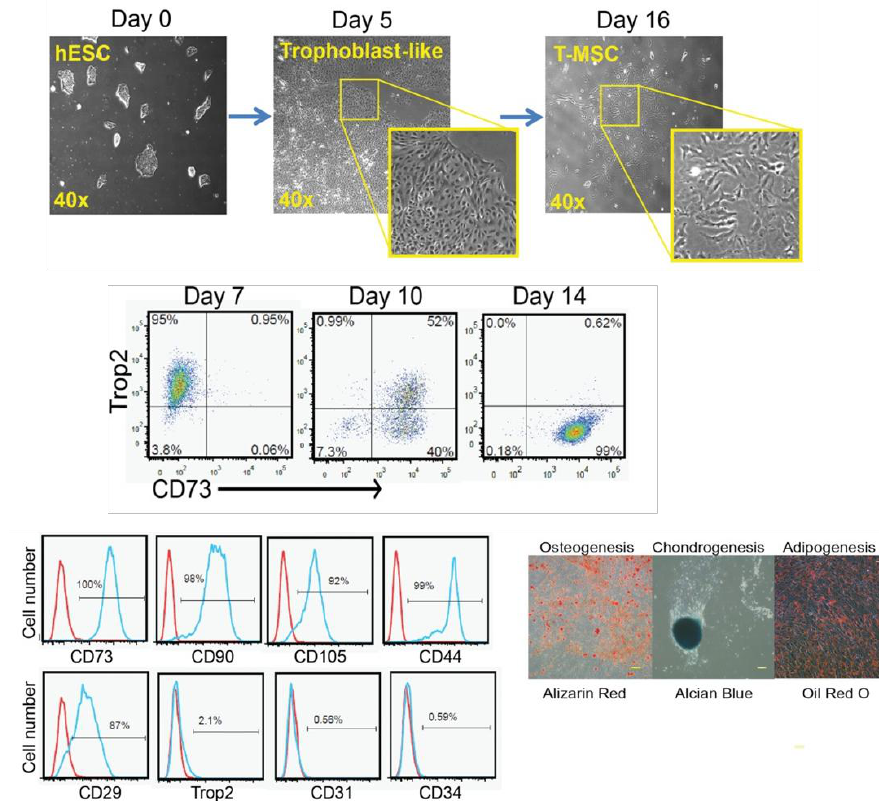
Figure 2. Stages of generation and characterization of human embryonic stem cells (hESC)-mesenchymal stem cells (MSCs) derived through the trophoblast-like stage as intermediate cells. The figure is reproduced from an article by Wang et al. 2016 [106] with permission from John Wiley and Sons. CD—cluster of di ff